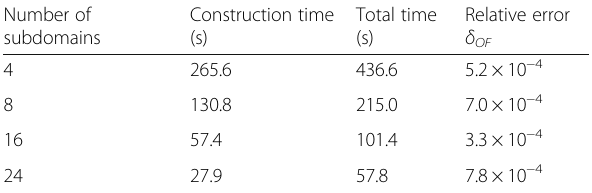
Table 1 Performance of the FETI-DP for calculating the optical force exerted on the silver nanocapsule with different number of subdomains Number of Construction time subdomains (s)